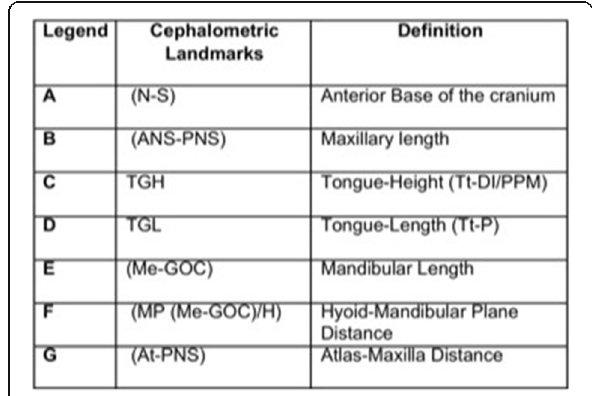
Fig. 2 Legend, cephalometric landmarks, and definition for sleep apnea analysis